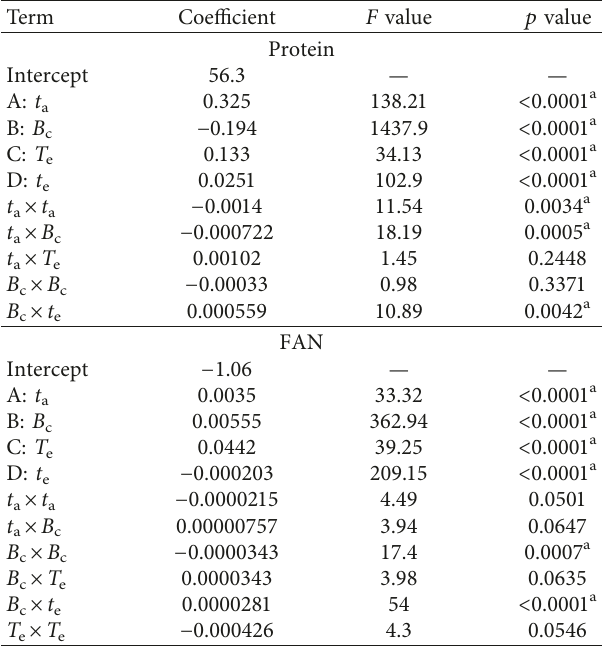
Table 3: Regression coefficients, F values, and p values of the variables and interactions in the equation models.